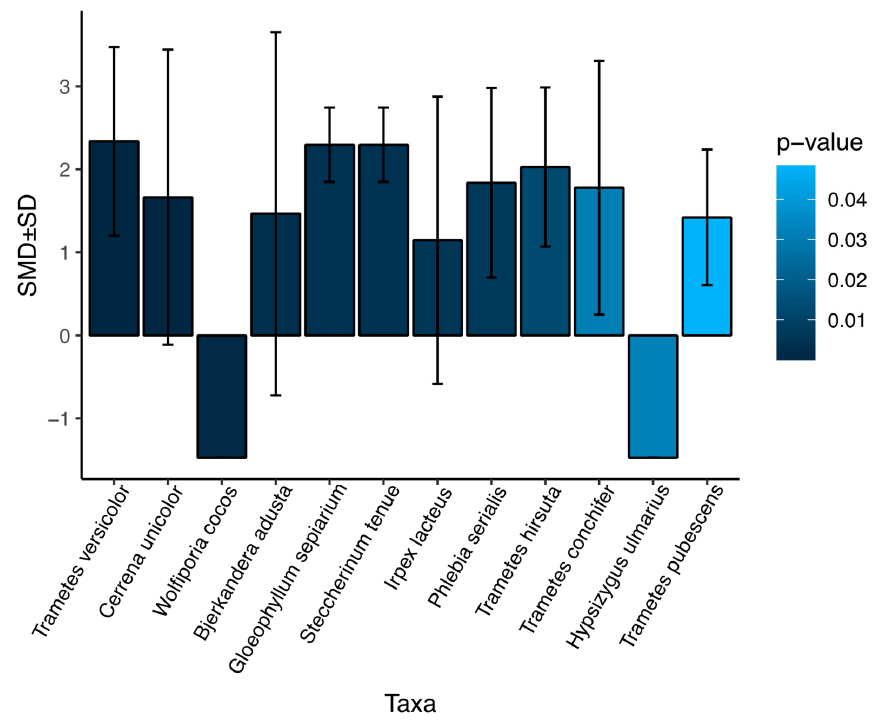
Figure 4. Fungal species with significant variations from the average of all isolates in this study. The difference in dye decolorization for an average of each species compared to the average of all isolates was determined by standardized mean difference (SMD) and p -value from the non-parametric Mann–Whitney Wilcoxon test. The variance within species was defined by the standard deviation (SD). The 12 species with a p -value < 0.05 were considered statistically different and plotted.